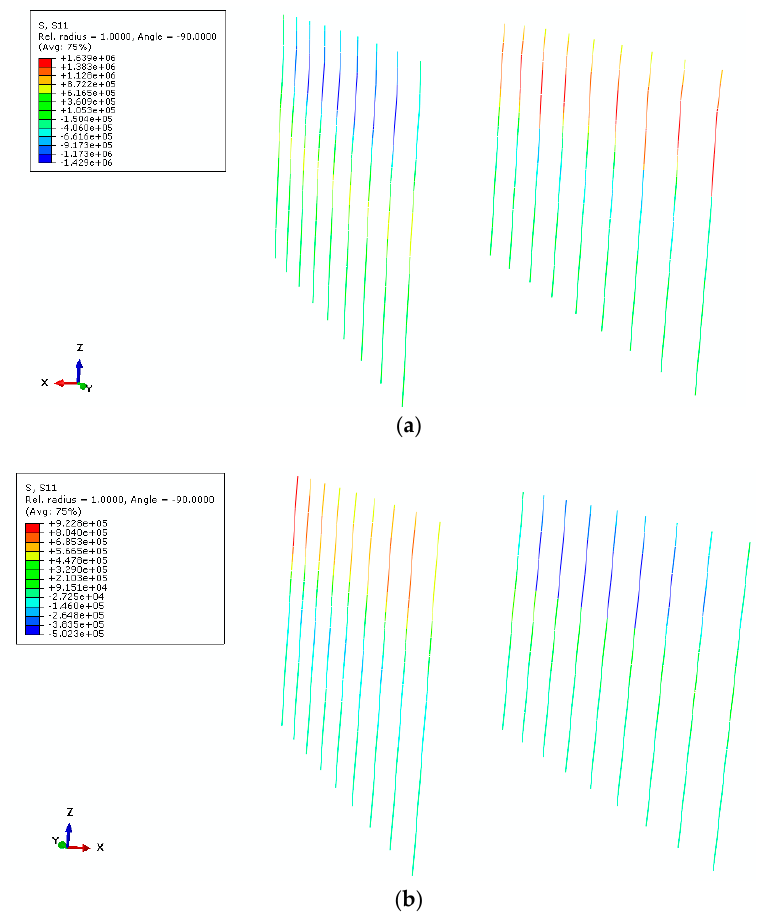
Figure 14. Shear shield cloud. ( a ) Left line tunnel; ( b ) Right line tunnel.